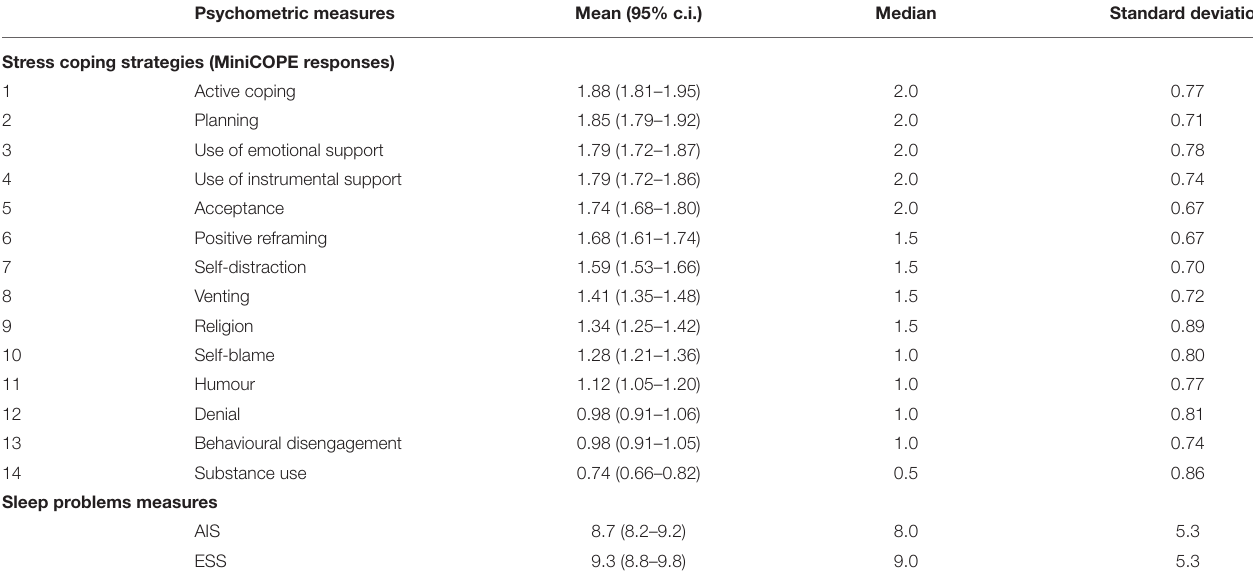
TABLE 1 | Descriptive statistics for measures of coping strategies and sleep problems among nurses ( N = 448). Psychometric measures Mean (95% c.i.) Median Standard deviation